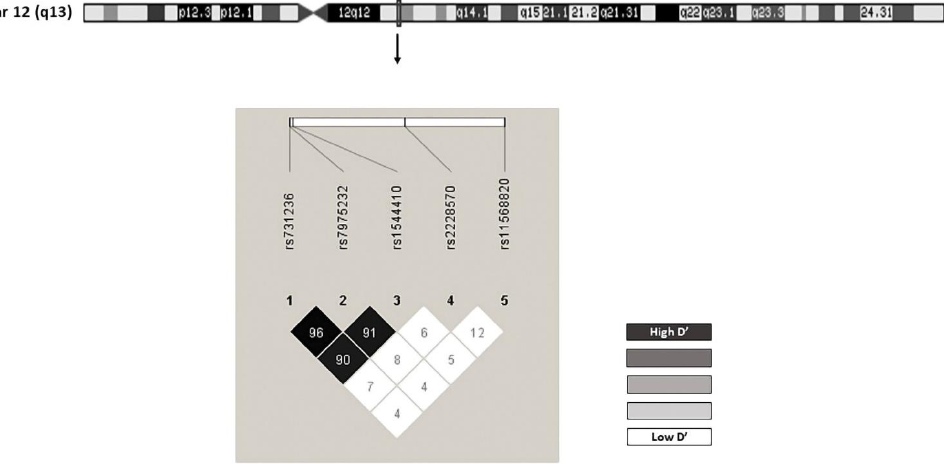
Figure 1. Chromosomal location for (vitamin D receptor) VDR , and linkage disequilibrium (LD).